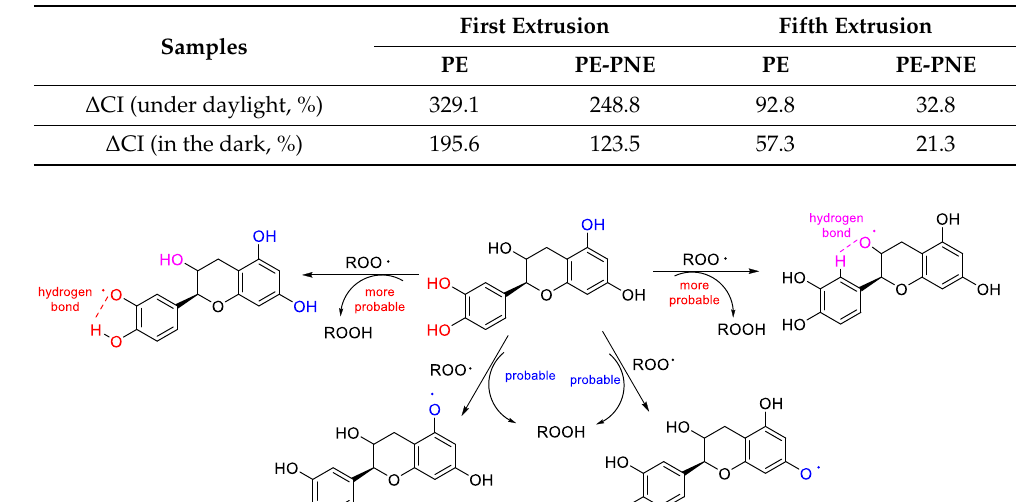
Scheme 2. Possible role of Catechin during thermo-oxidation.